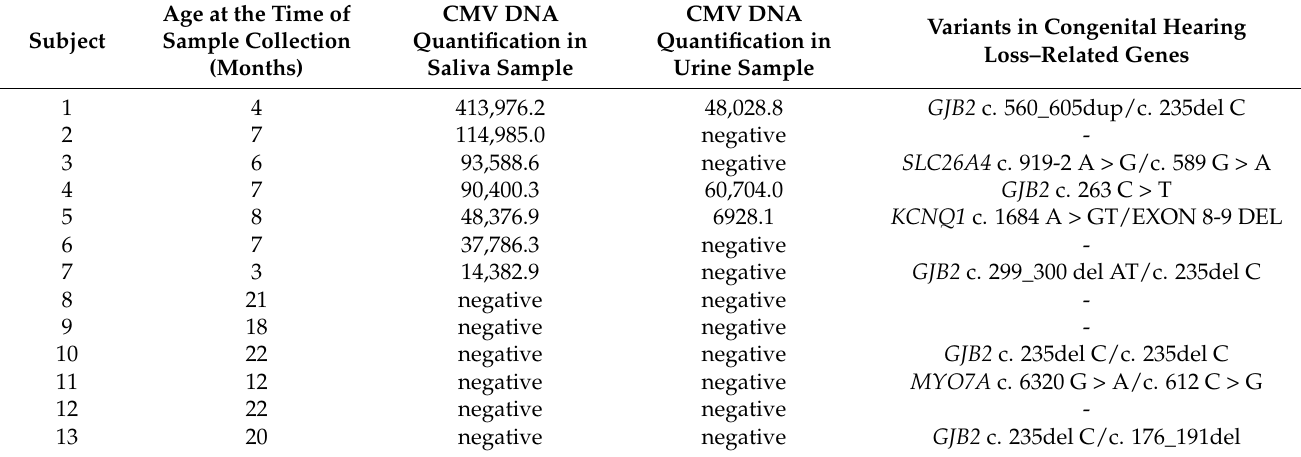
Table 1. Information on all children with CMV-positive or CMV-false positive